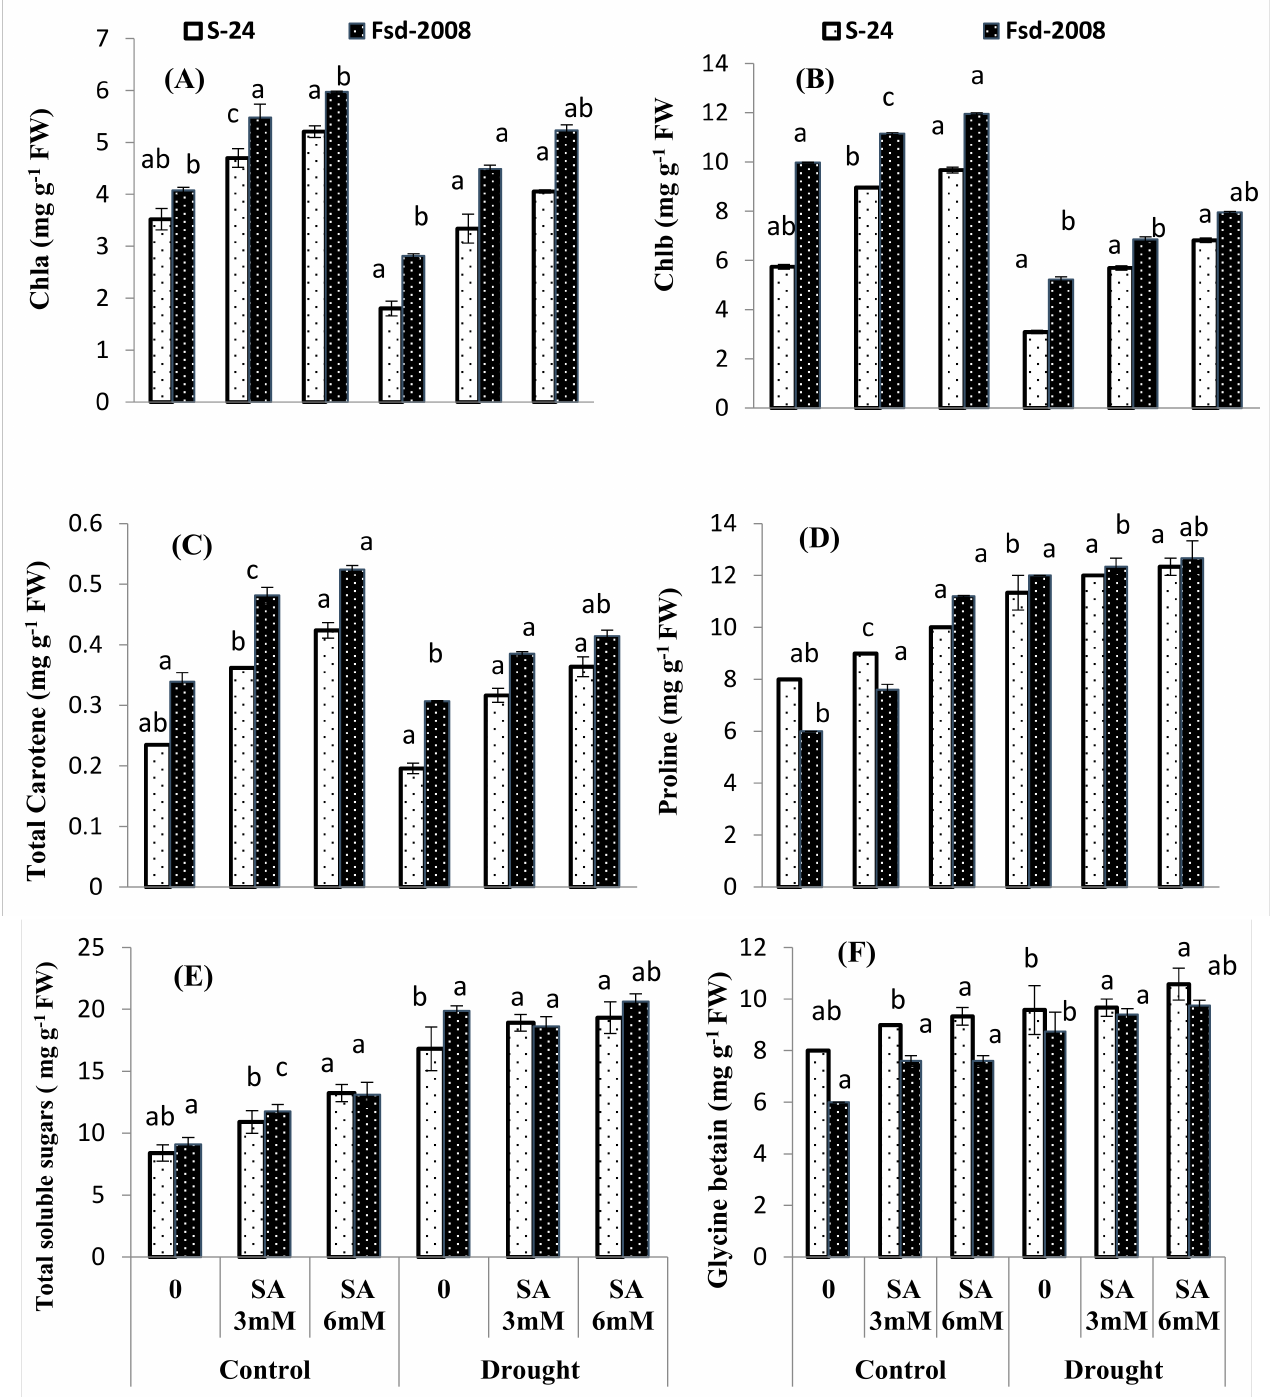
Figure 2. Effect of foliar-application of salicylic acid on ( A ) chlorophyll a, ( B ) chlorophyll b, ( C ) carotenoids, ( D ) proline, ( E ) total soluble sugar contents, ( F ) glycine betaine contents in two wheat cultivars under water-stress conditions. Means with the same letter (S) do not differ significantly at p ≤ 0.05. Error bars above the means indicate standard error ( n =